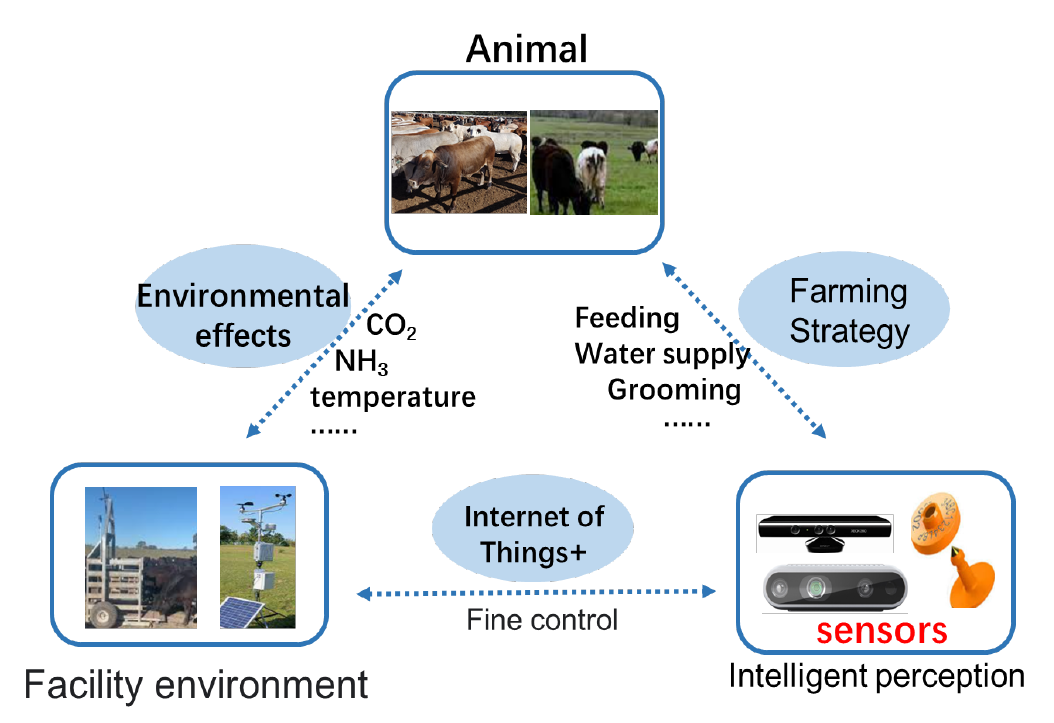
Figure 1. The framework of intelligent perception-based animal